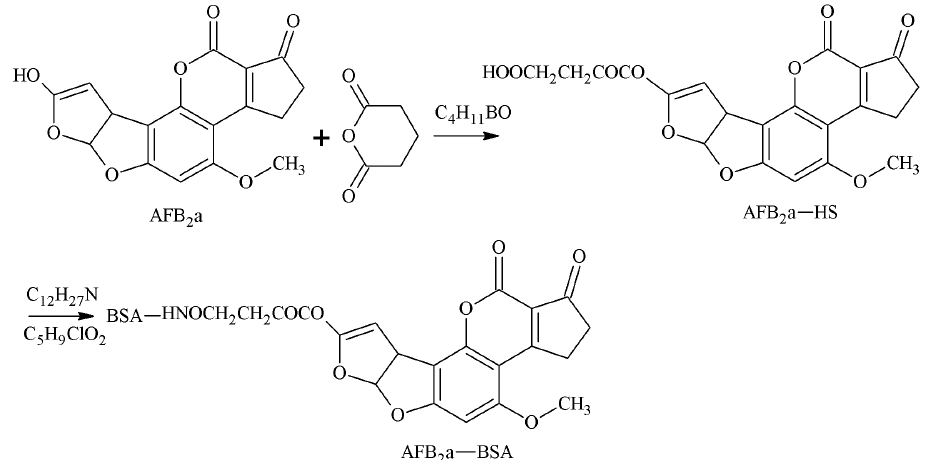
Figure 4. Synthesis of the AFB1-BSA antigen by the mixed anhydride (MA) method.